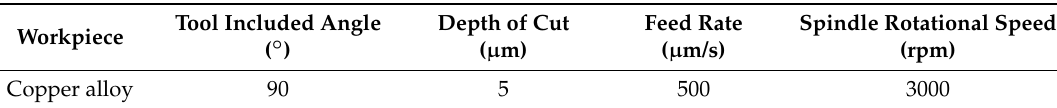
Figure 4. Structural layout of ultra-precision machine tool and on-machine fly-cutting. Table 1. The experimental conditions of fly-cutting.